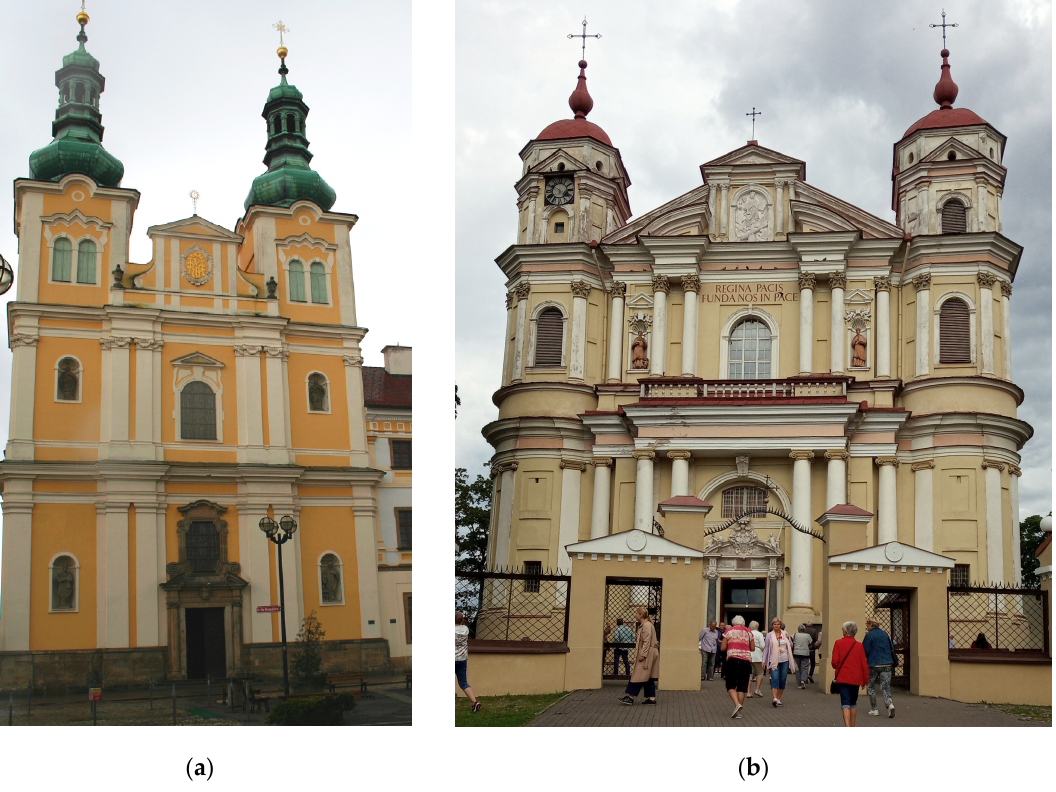
Figure 14. Composition with continuous vertical elements in architectural orders: ( a ) the façade of the church of the Assumption of the Virgin Mary in Hradec Králové (1654–1679) by C. Lurago; ( b ) the façade of the church of St. Peter and Paul on Antokol in Vilnius (1670s). Photos by author. Simultaneously with the development of the dynamics of architectural forms in